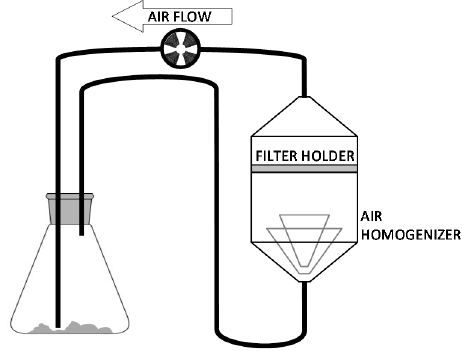
Figure 3. Schema of the apparatus to deposit calibrated amounts of particles on the filters.